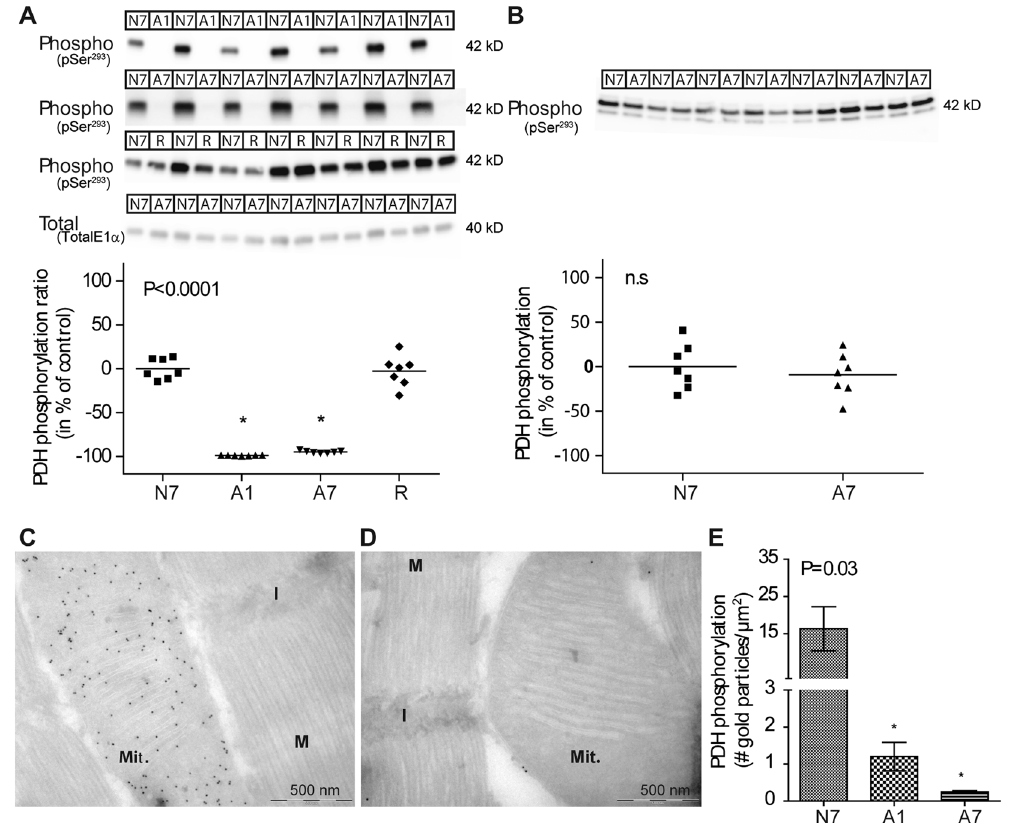
Figure 2. Phosphorylation of crucian carp E1 α subunits in normoxia (N7) and anoxia (A7). ( A , B ) Phosphorylation of E1 α subunits in relation to N7 (n = 7) are shown for red muscle ( A ) and brain ( B ). Western blot images include staining using antibodies against phosphorylated PDHc (upper three images in A and image in B ) and against total E1 α (lower image in A ). Statistical difference compared to N7 is indicated by * (p < 0.0001). n.s = not significant; kD = kilodalton. (C , D) EM micrographs of crucian carp red muscle showing gold-staining of phosphorylated E1 α subunits during normoxia (C) and anoxia (D) . Mit. = mitochondria; I/M = visible bands of muscle fibers. (E) Quantification of gold particles per µ m 2 in red muscle following N7, A1 and A7 (Means ± S.E.M. of 3 individuals per group). (See legend to Fig.